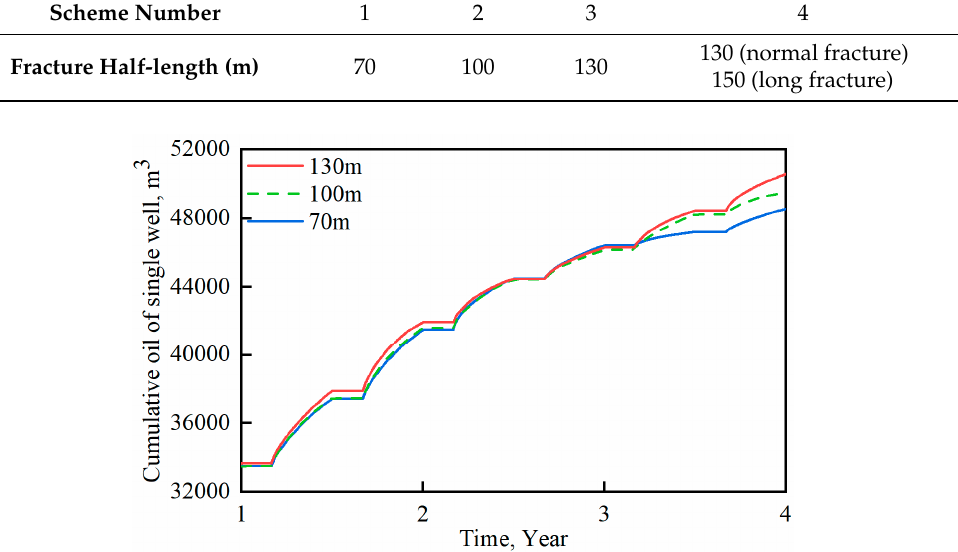
Table 12. Fracture half-length in di ff erent schemes. Table 13. Calculation results of different fracture half-lengths. Table 13. Calculation results of different fracture half-lengths.